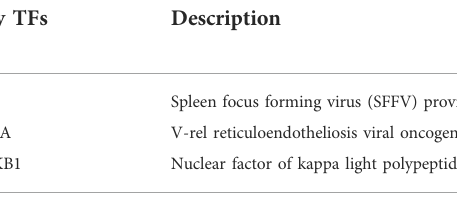
TABLE 3 Key transcription factors (TFs) of hub